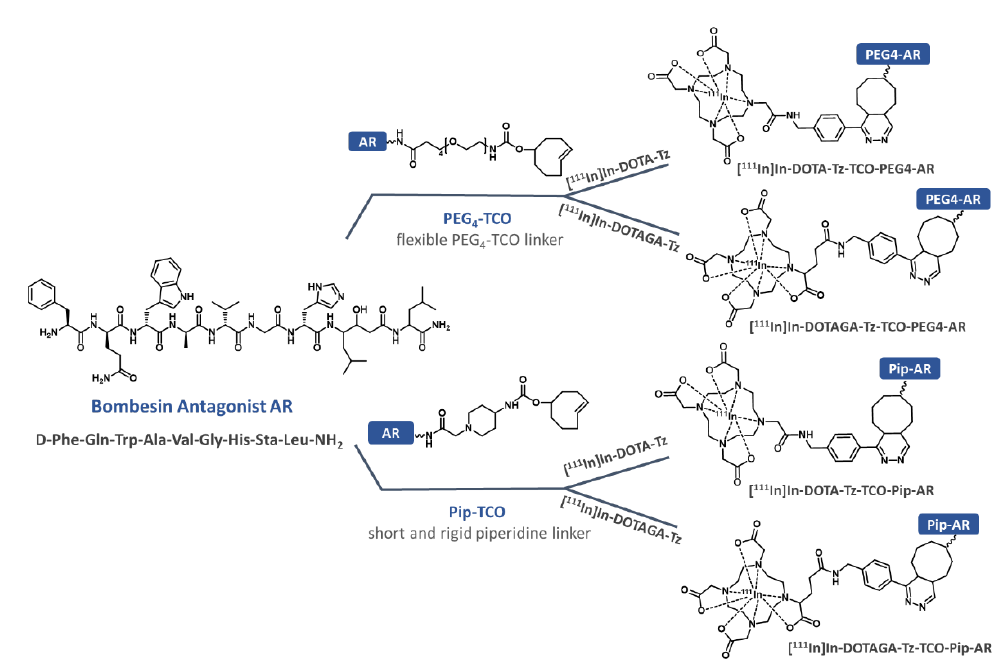
Figure 2. Synthesis of the 111 In-radioconjugates by click reaction between the clickable antagonists AR-PEG 4 -TCO and AR-Pip-TCO and the clickable radiocomplexes [ 111 In]In-DOTA-Tz and [ 111 In]In -DOTAGA-Tz.